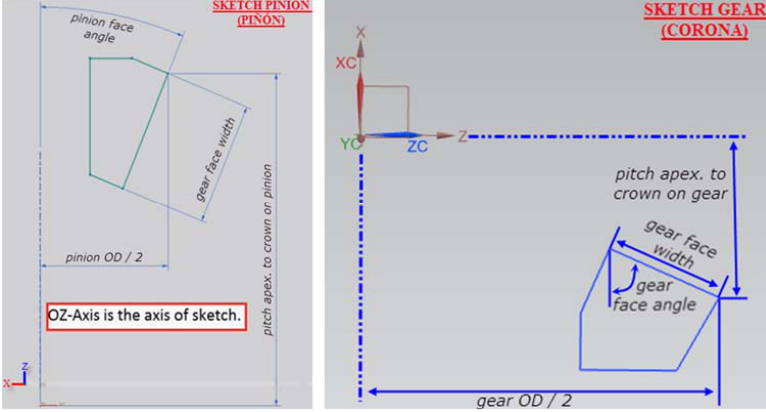
Figure 2. 2D geometry provided by 3D spiral bevel gear software.